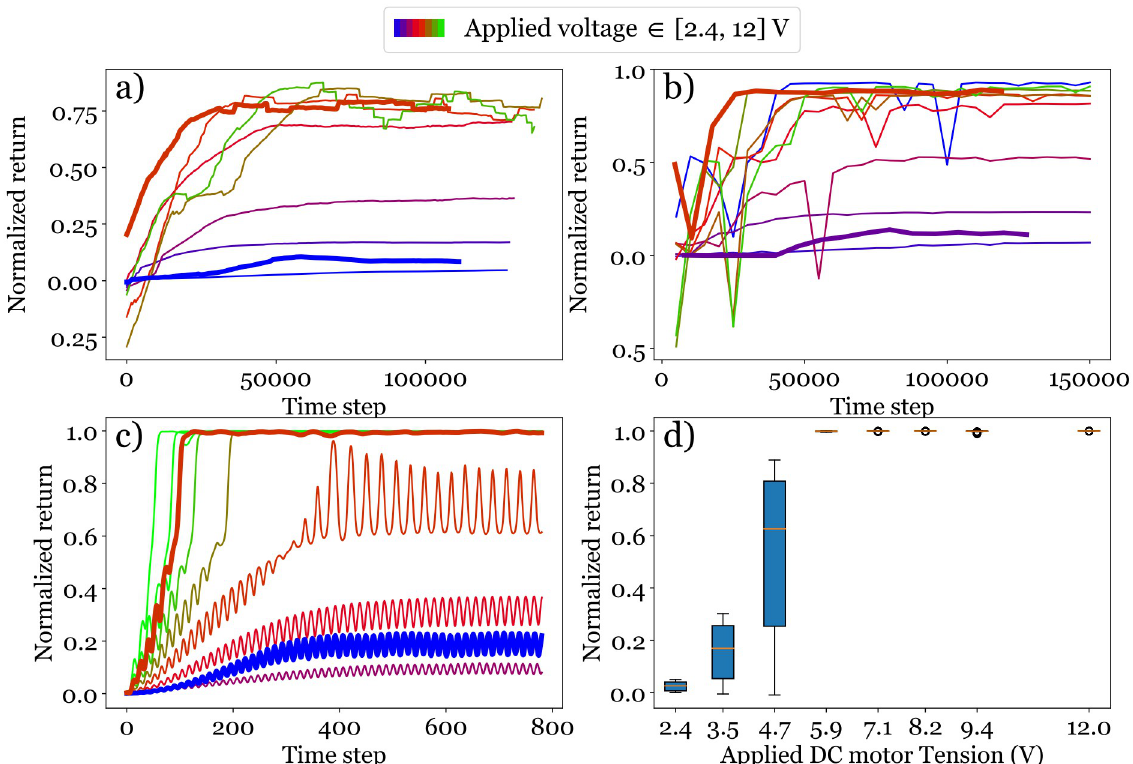
Fig 6. Influence of the applied voltage on the learning process. Thin curves correspond to different simulations, while thick curves refer to the experimental observations. a) Learning curve. b) Inference curve built from inferences performed every 5000 time steps. c) Temporal evolution of the reward for the episode initiated at θ 0 = 0 following the best learned policy. d) Statistics over 10 episodes initiated with θ 0 between − 10˚ and 10˚ of the plateau reward following the best learned policy.